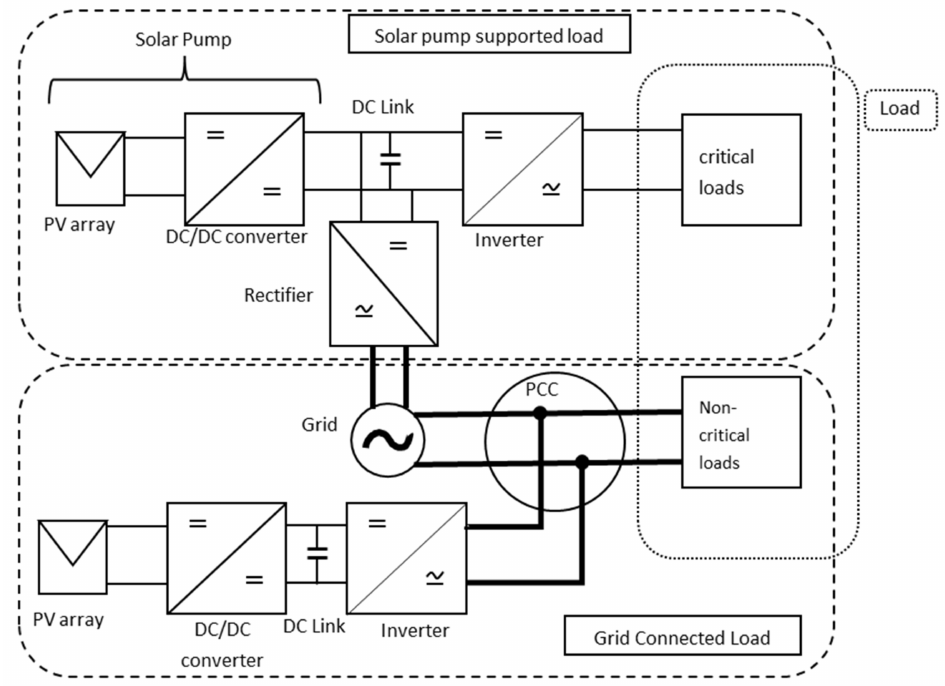
Figure 1. Proposed system